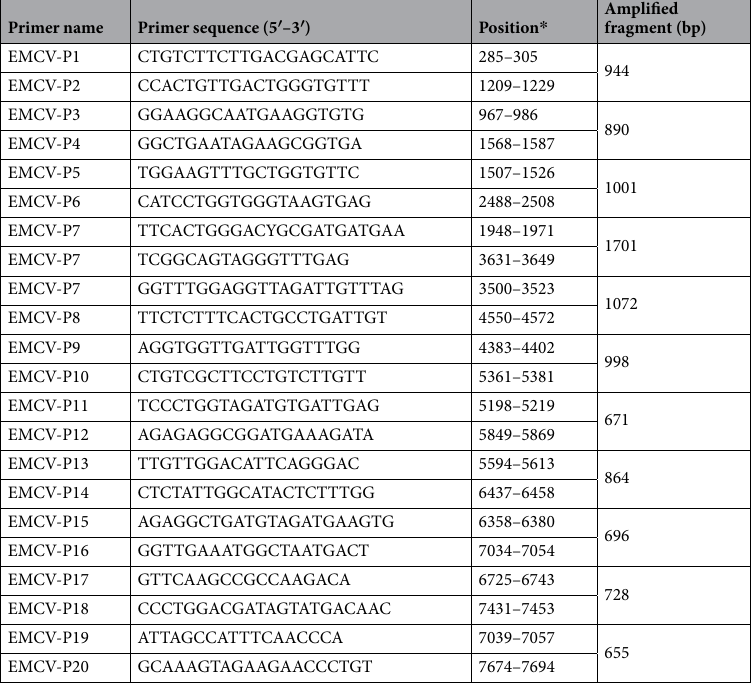
Table 1. Primers used for RT-PCR amplification. EMCV-specific primers were designed based on the ORF sequence of the BJC3 strain (DQ464062). DNA fragments corresponding to the ORF of EMCV-C15 were amplified, and amplicons were sequenced commercially (Huada, Beijing). Sequence assembly was carried out using the SeqMan program included with the DNASTAR software package (Madison, WI). * Nucleotide position is based on the sequence of EMCV strain BJC3